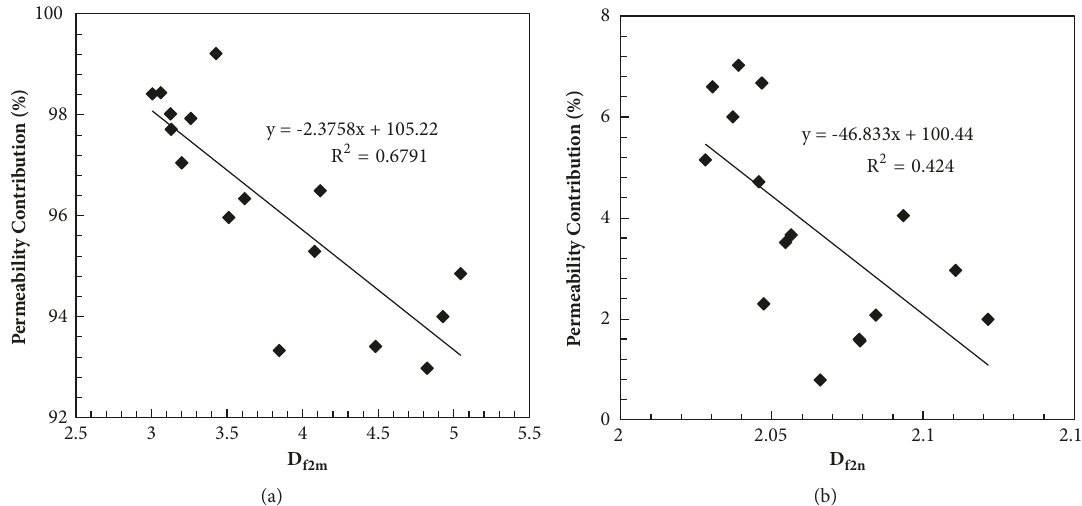
Figure 13: Relationship between fractal dimension and permeability contribution ((a) microscale pores; (b) nanoscale pores).